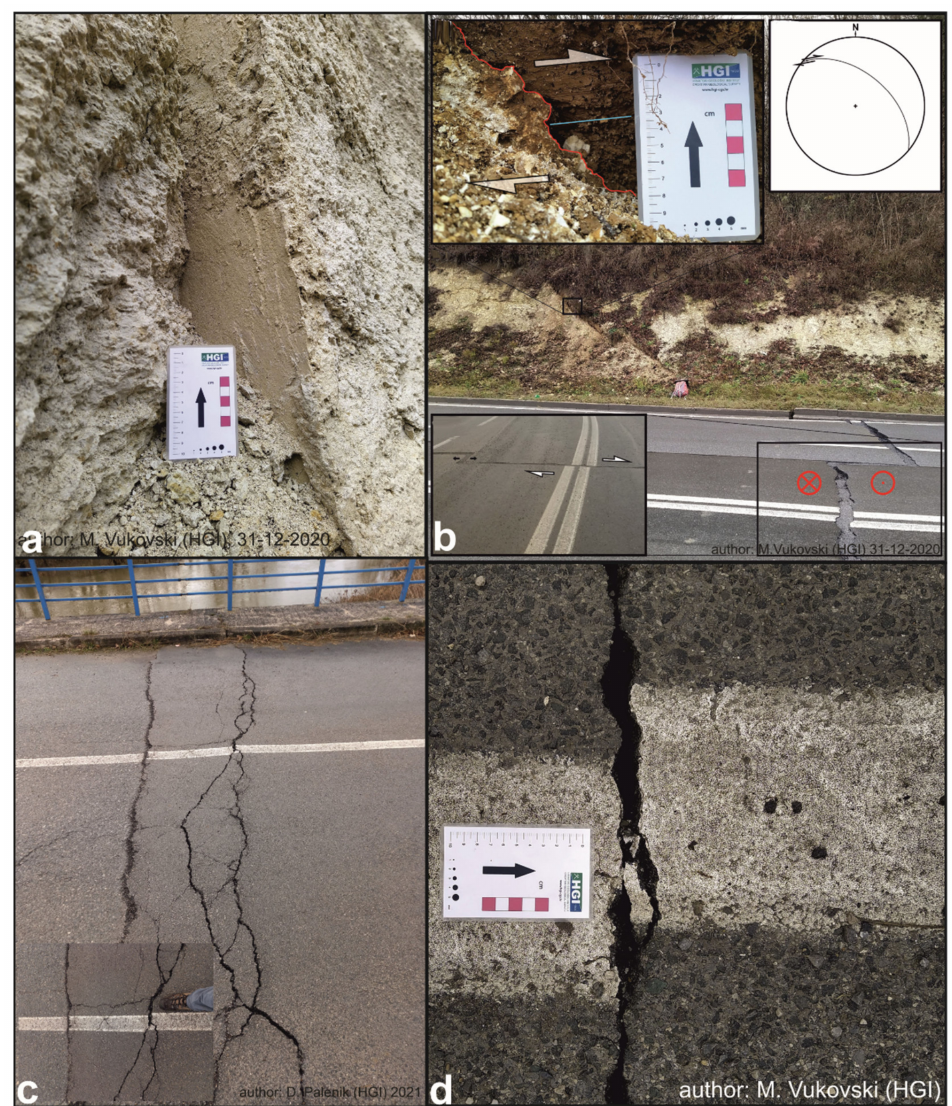
Figure 6. ( a ) The dextral coseismic displacement along the NW–SE striking subvertical fault plane in an abandoned quarry SW of Župi´c (WGS: 45.4229/16.2243); ( b ) Dextral coseismic displacement across a road west of Župi´c. Note fresh sub-horizontal striations in the soil (WGS: 45.4239/16.2226). Insets show the fault details with marked displacement and the fault surface projection on the lower hemisphere; ( c ) Sinistral displacement of a bridge NE of Glina (WGS: 45.3697/16.1183); and ( d ) Sinistral displacement on the road W of Petrinja (WGS: 45.4449/16.2590). The locations of the field photographs are presented in Figure